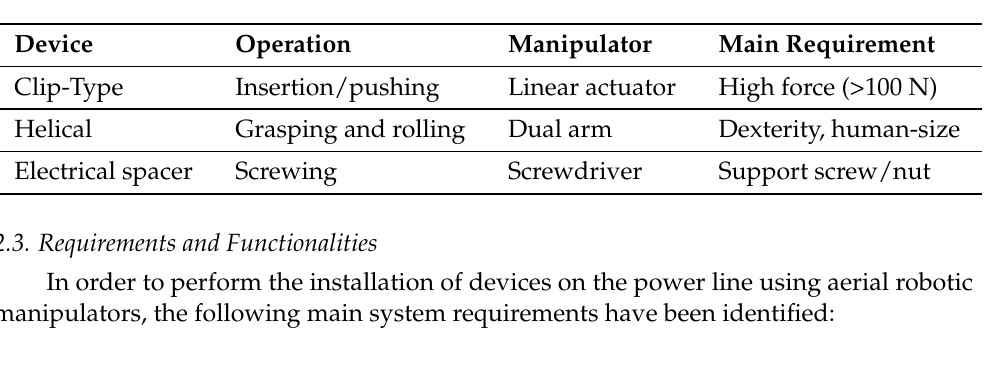
Table 1. Procedure for the installation of the different